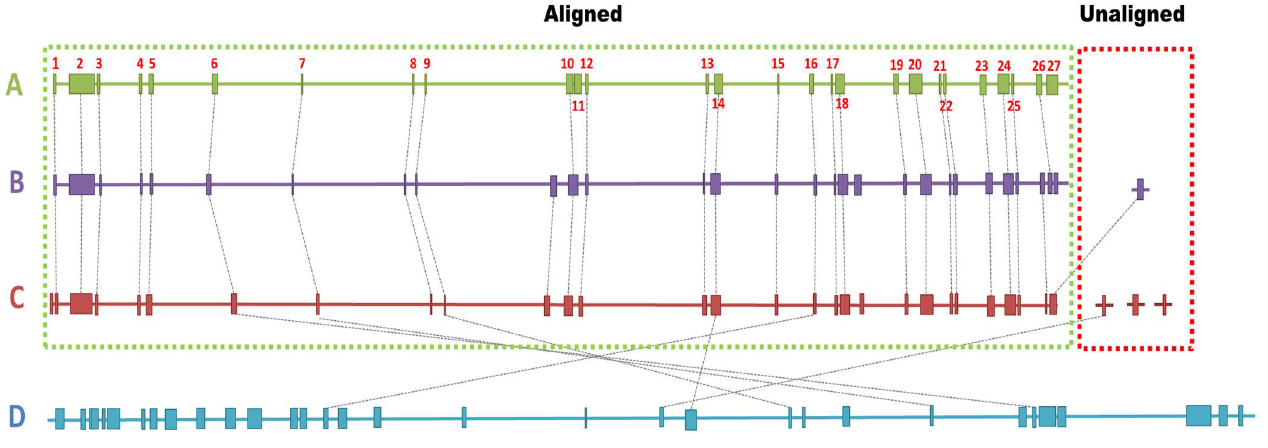
Figure 8. A relation between 27 biosynthetic gene clusters among A ( S. vinaceusdrappus strain AC- 40) as a reference, B ( S. vinaceusdrappus strain JCM 4529), C ( S. plicatus strain JCM 4504), and D ( S. rochei strain 7434AN4). The labels aligned and unaligned indicate the contigs from genomes B and C that were successfully and unsuccessfully aligned on the genome A as reference for reference-guided scaffolding.